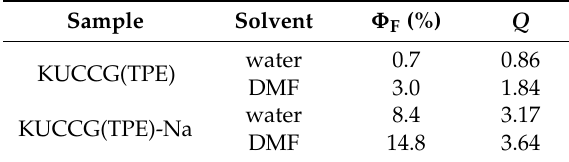
Table 1. Summary of photoluminescence quantum yield ( Φ F ) and swelling degree ( Q